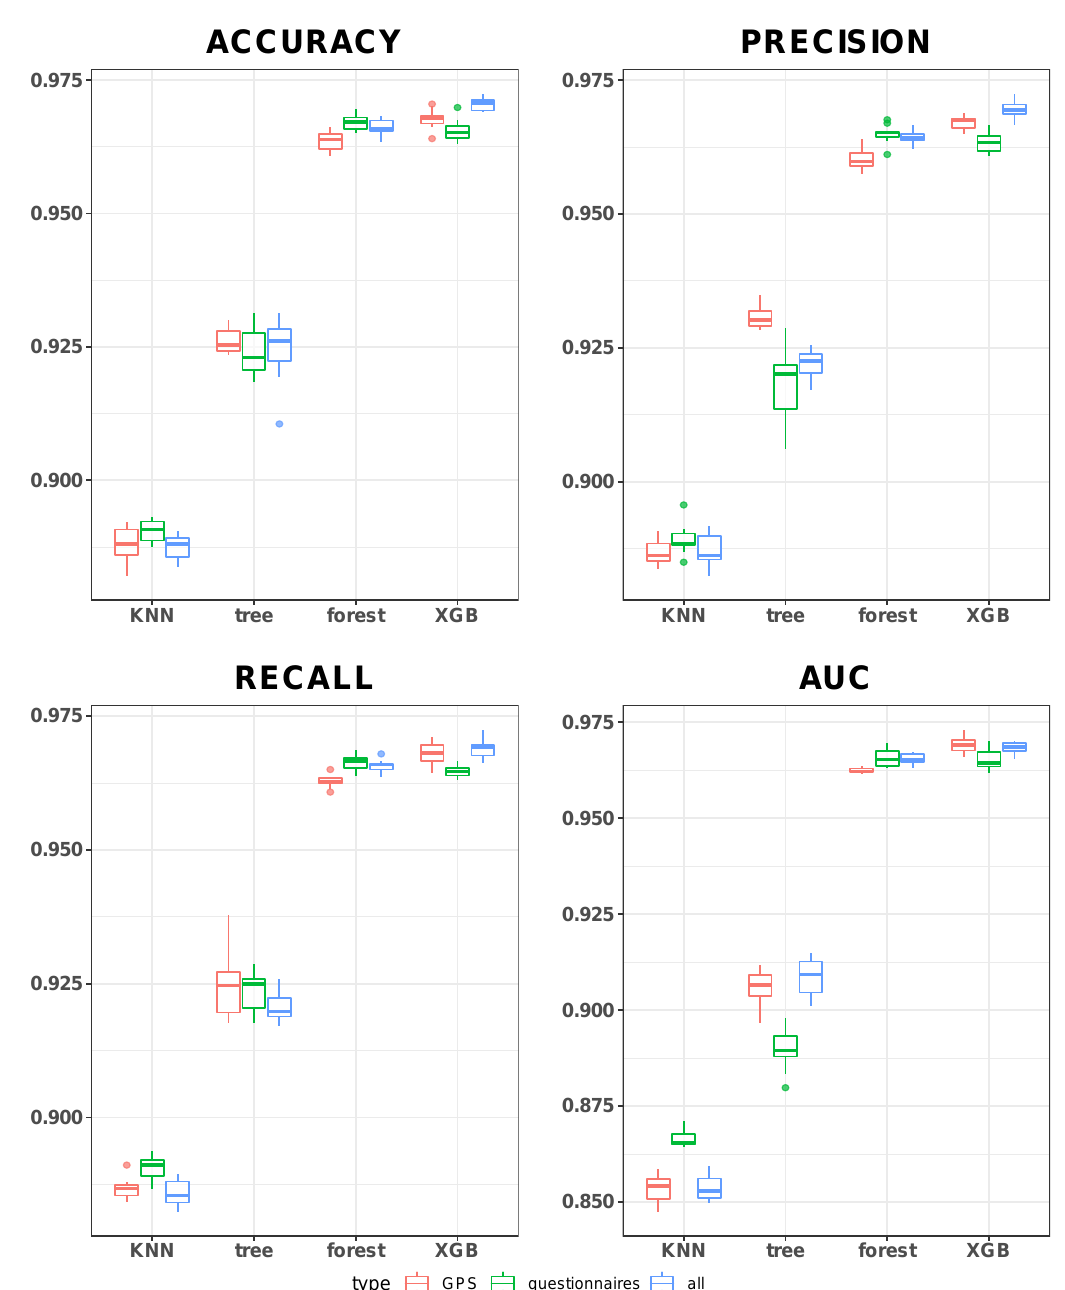
Figure 4. One-month predictive performance of best models according to three types (in color) of data sets. Predictive results are presented as box plots, in which the box indicates quartile values; the whiskers indicate the upper and lower values; circle indicates